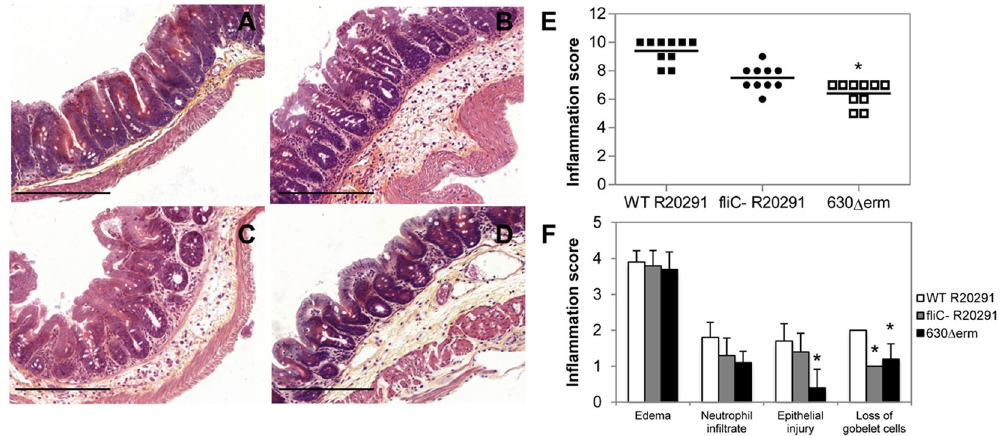
Figure 3. C. difficile flagella and caecal inflammation in C57BL/6 tlr5 − / − KO mice. C57BL/6 tlr5 − / − KO mice (n = 10) were infected by oral gavage or not and caeca were collected at the clinical end point day 2 for histology. ( A ) Representative histology of caecum of healthy uninfected mice (control) with epithelium integrity; ( B ) R20291 WT-infected mice with mild to moderate edema; ( C ) R20291 fliC mutant and ( D ) 630 Δ erm WT- infected mice with mild to moderate edema (200X magnification). Bar = 200 µ m. ( E ) Inflammation histological scores for individual mice in each group. The horizontal lines represent the mean scores for each group of animals. ( F ) Individual evaluation criteria of intestinal inflammation. The bars represent the mean scores for each group of animals and standard deviations. * P < 0.01 compared to R20291 WT-infected